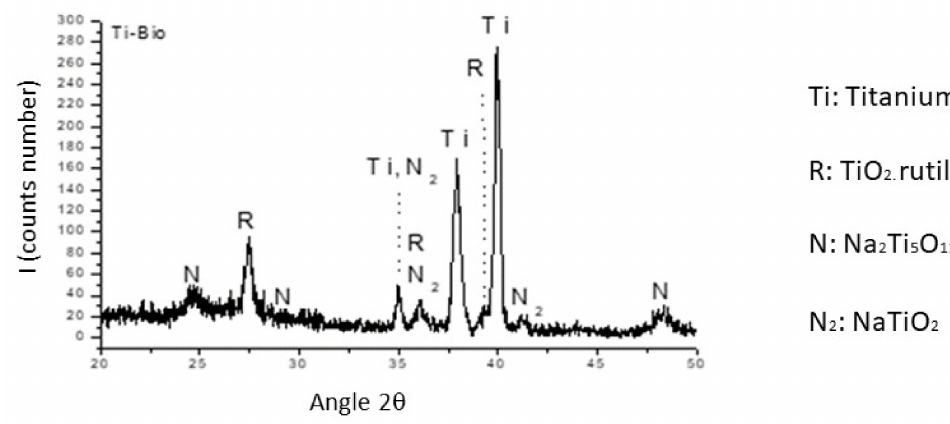
Figure 5. X-ray diffractogram of the titanium surface with apatite. When sodium titanate is immersed in a solution simulating human plasma, it shows the appearance of apatite crystals [44–46]. This SEM observation is depicted in Figure 6.